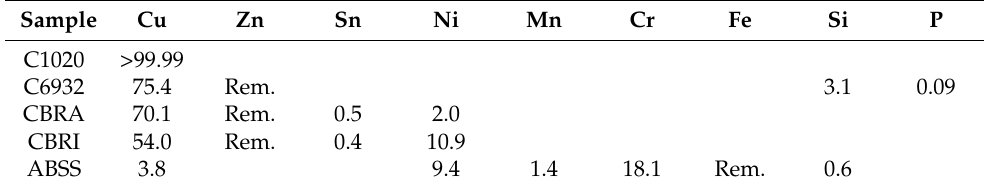
Table 2. Chemical compositions of oxygen free copper and alloy samples (wt.%).